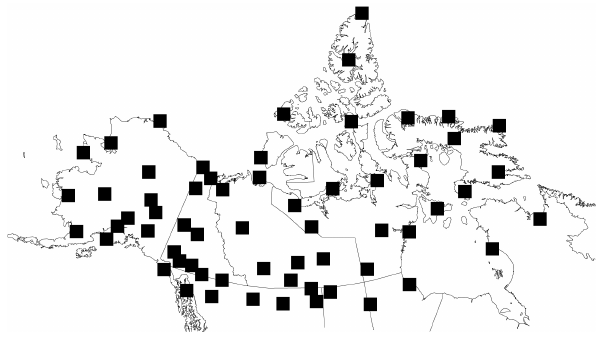
Fig. 2. Locations of stations used for CRCM temperature adjust- ment; 15 stations within Alaska and 47 stations within